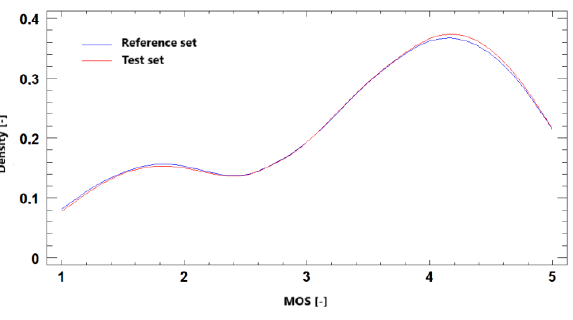
Figure 20. The probability density function for MOS prediction, Ultra HD, H.264 + H.265.